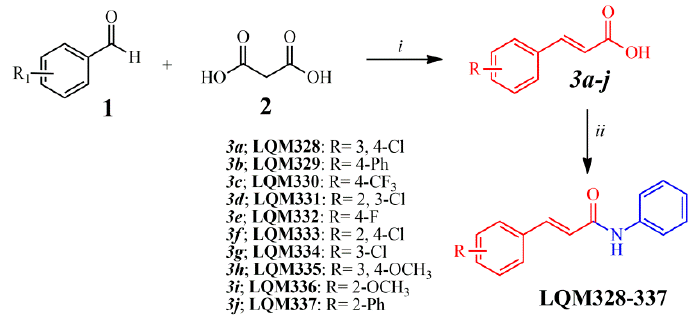
Figure 3. Synthetic route applied for the obtainment of acrylamide derivatives. Reagents and reactional conditions: (i) Pyridine, N-methylpiperazine (10 mol%), 24 hours, reflux; (ii) Aniline, dimethylformamide (DMF), 2-(1H-Benzotriazole-1-yl)-1,1’,3,3’-tetramethyluronium tetrafluoroborate (TBTU), diisopropylethylamine (DIPEA), 24 hours, at room temperature.